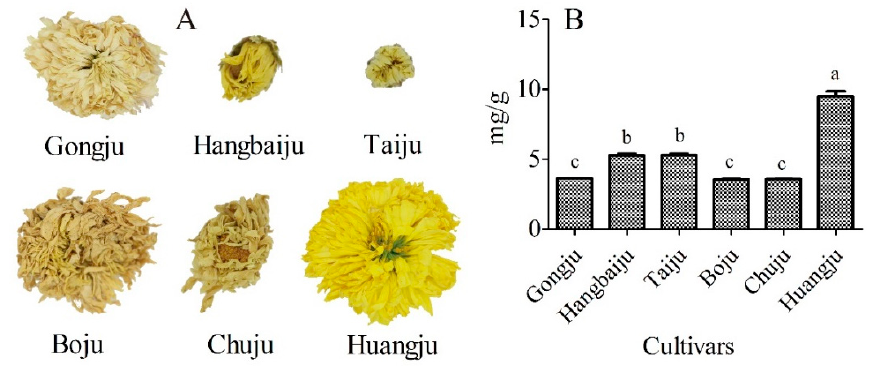
Figure 1. Screening the appropriate cultivar for the extraction and purification of apigenin ‐ 7 ‐ O ‐ glucoside. A . The flowers of Chrysanthemum morifolium ‘Gongju’, C. morifolium ‘Hangbaiju’, C. morifolium ‘Tai’, C. morifolium ‘Boju’, C. morifolium ‘Chuju’, and C. morifolium ‘Huangju’. B . Content of apigenin ‐ 7 ‐ O ‐ glucoside in different cultivars. Means indicated by different letters differed